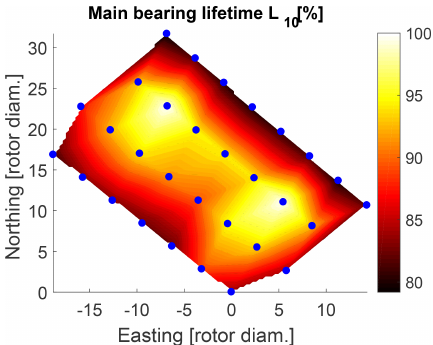
Figure 15. Example for percentage of start-up and shutdown events per wind speed for Turbine 19 (marked with blue circle in Fig. 14).